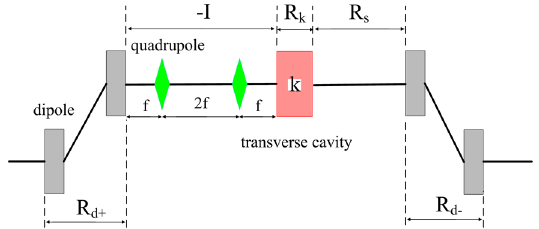
FIG. 2. A chicane-type exact EEX beam line. Two quadrupoles (green diamonds) are put upstream of the transverse cavity to reverse the